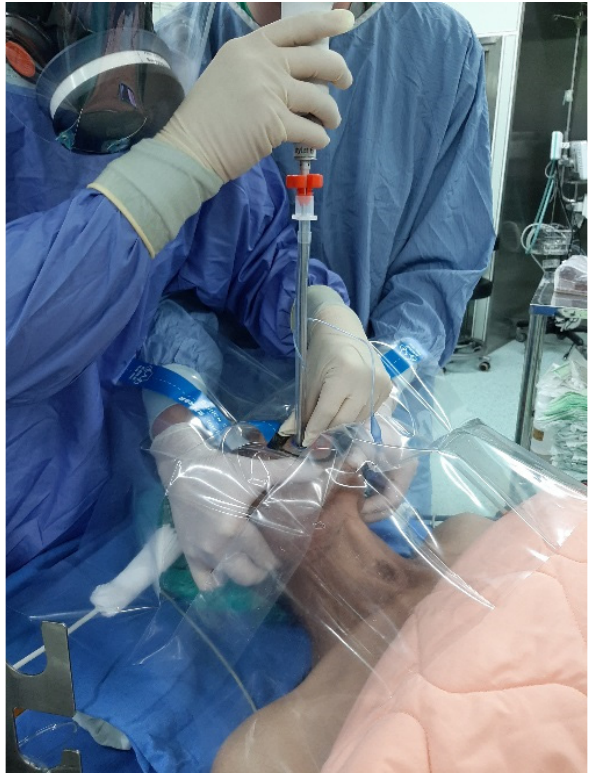
Figure 7. Tracheal intubation through a piece of plastic sheet barrier (The same patient as the one in Figures 6 and 8).